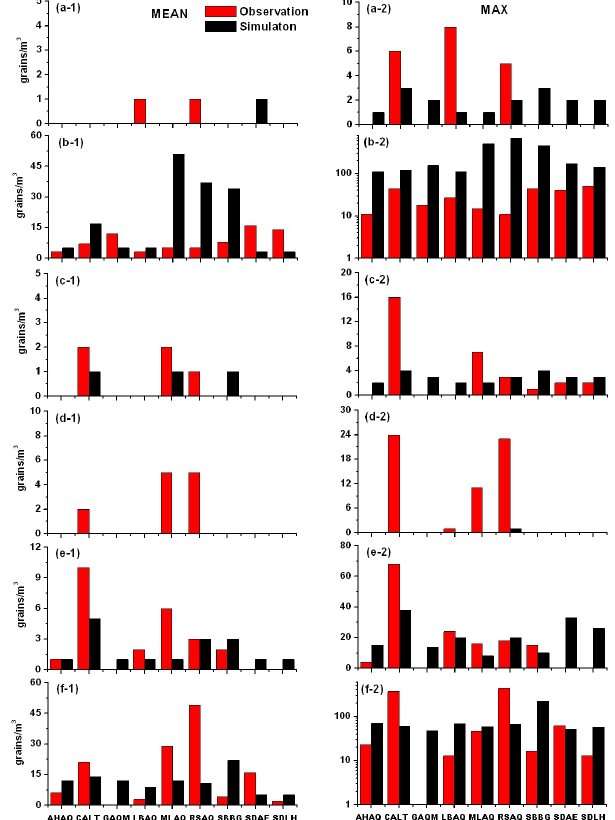
Fig. 9. Modeled vs. observed mean (left panel) and maximum (right panel) pollen concentrations at nine observation sites for (a) birch, (b) grass, (c) walnut, (d) mulberry, (e) olive, and (f) oak.